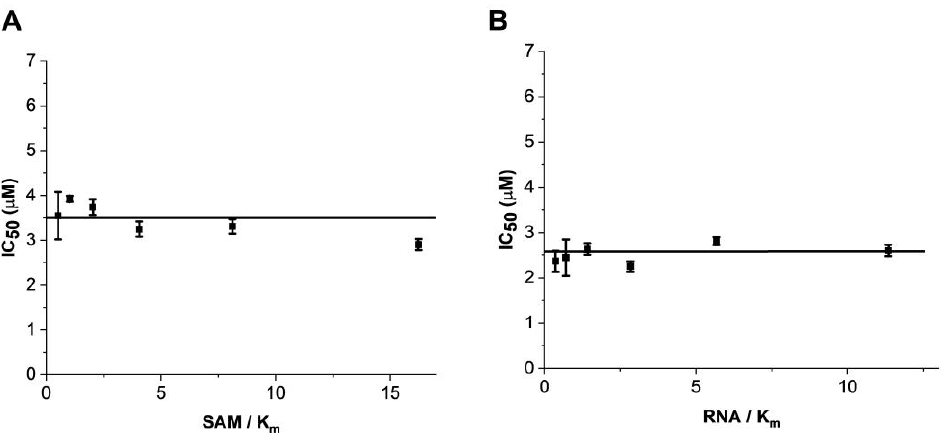
Figure 4. Studies on the mechanism of action showed that eltrombopag inhibited the METTL3-14 complex in a noncompetitive manner. ( A ) IC 50 values of eltrombopag at increasing concentrations of SAM ranging from 50 to 1,600 nM at fixed concentrations of RNA substrate (2 μ M). ( B ) IC 50 values of eltrombopag at increasing concentrations of RNA substrate ranging from 25 to 800 nM at fixed concentrations of SAM substrate (3 μ M).